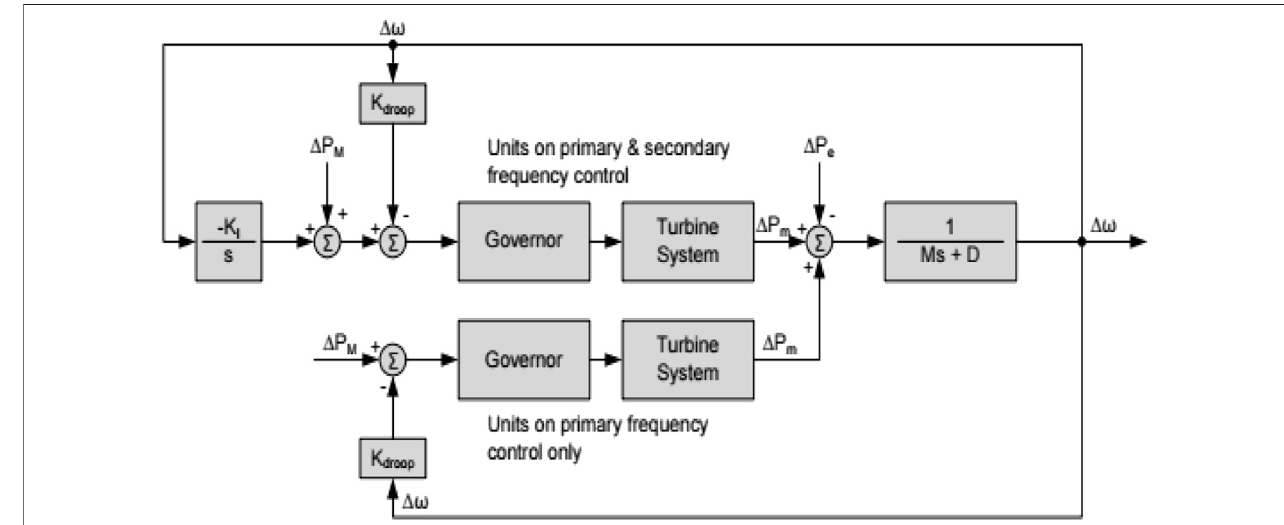
FIGURE 3 | Frequency control scheme in power